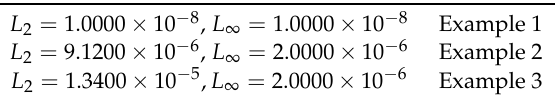
Table 1. Error norms of